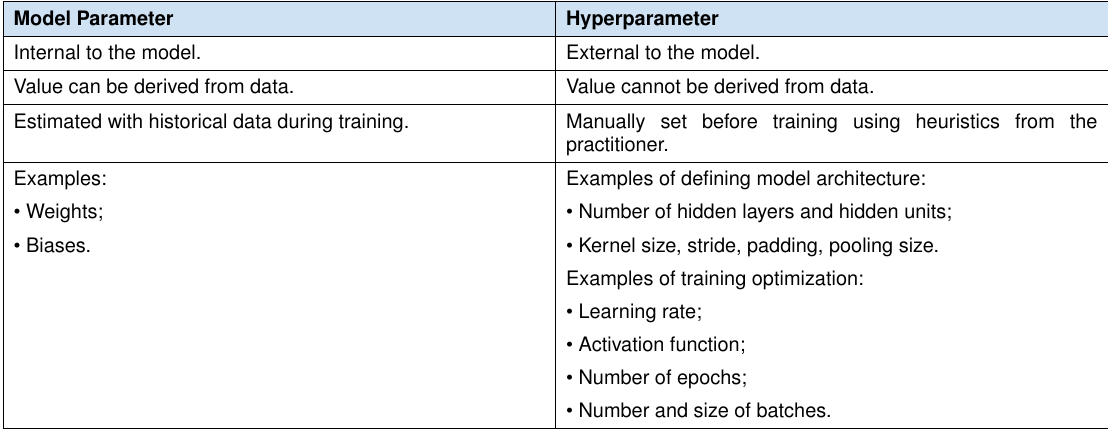
Table 6. Difference between model parameters and